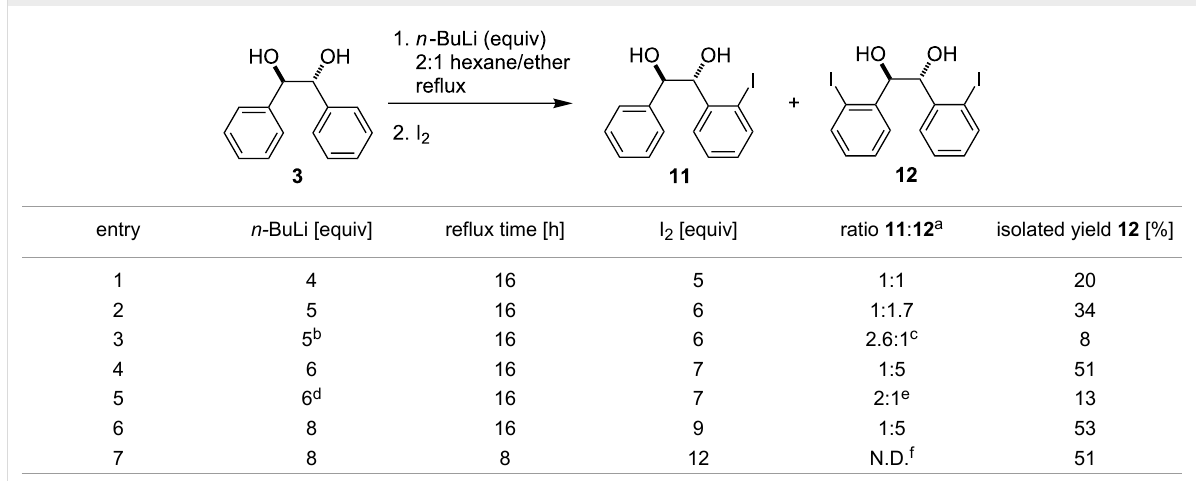
Table 1: Optimization of the synthesis of the diiodohydrobenzoin 12